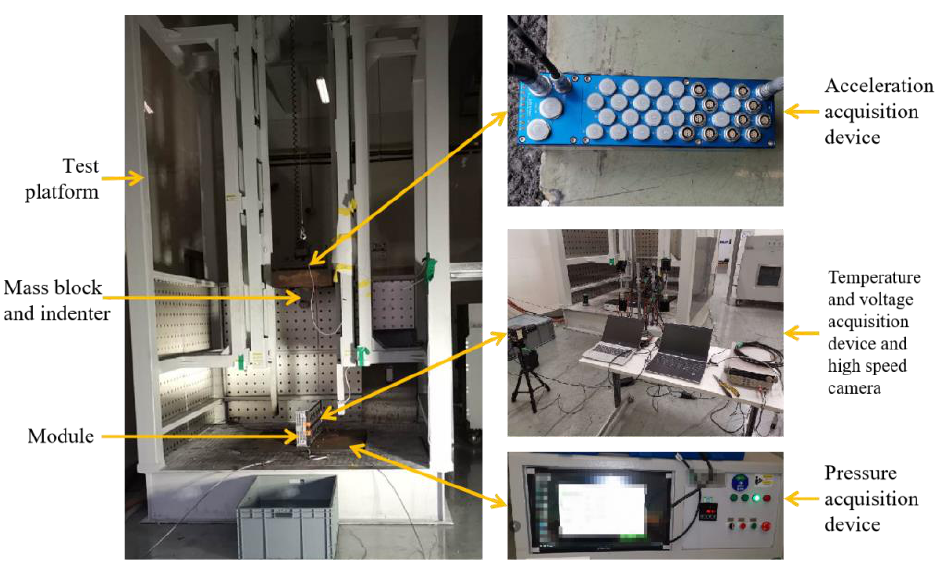
Figure 4. Schematic of the drop-weight test